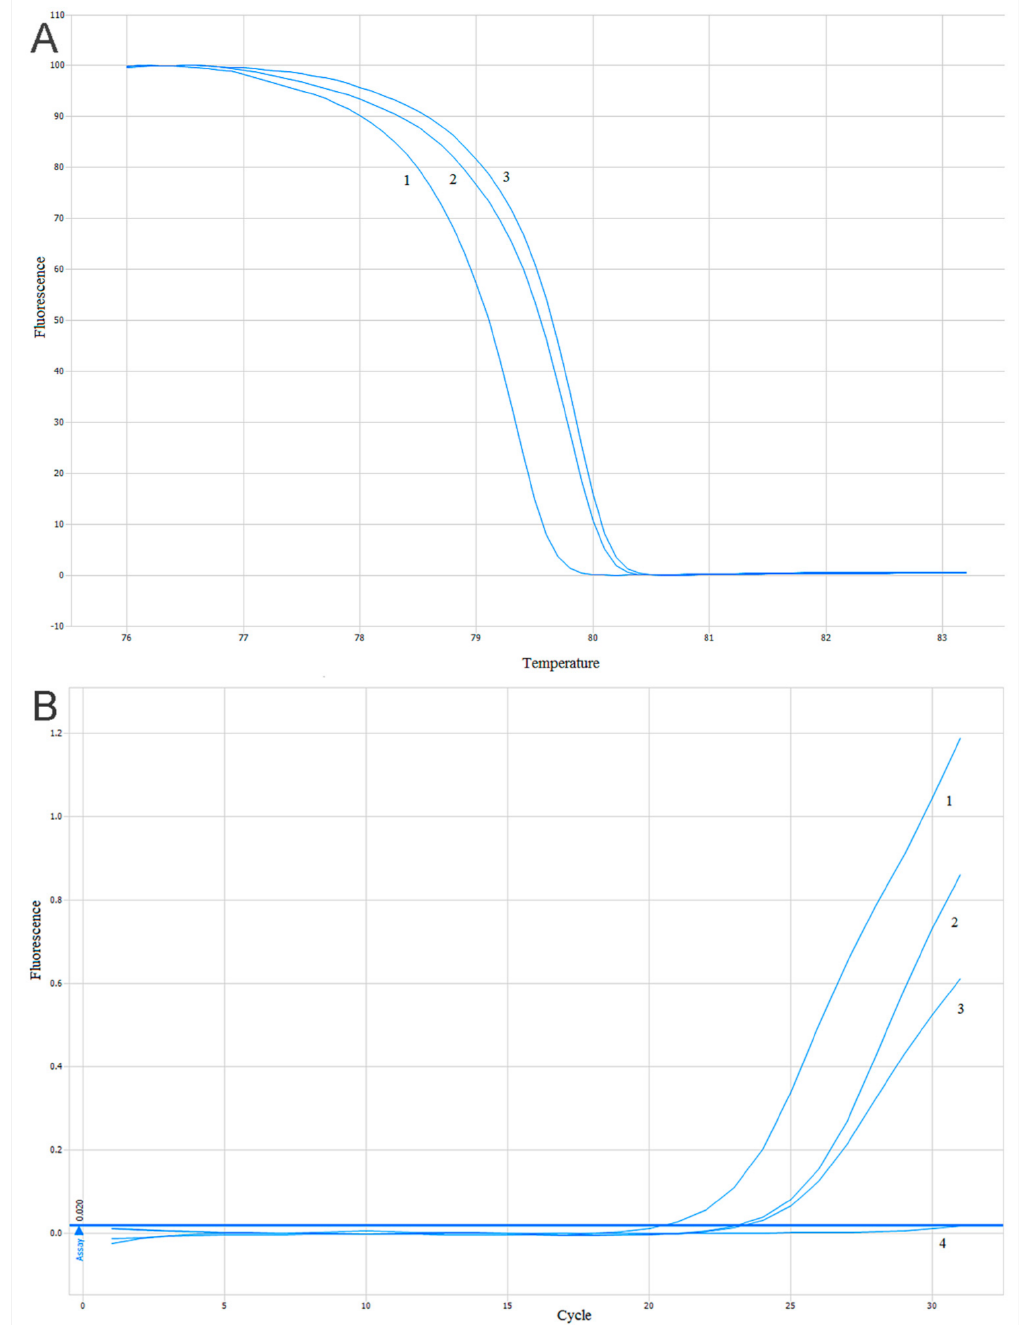
Figure 8. Sample analysis of the results of the High-Resolution Melt PCR (HRM-PCR) and Allele-Specific-quantitative PCR ASP-qPCR reactions: ( A ) analysis of the melting curves of the HRM-PCR reaction products for the PIK3CA gene. 1. Negative control. 2. Studied sample. 3. Positive control; ( B ) analysis of the ASP-qPCR reaction product amplification for the PIK3CA gene. 1. Negative control. 2. Studied sample. 3. Positive control. 4. Negative DNA control